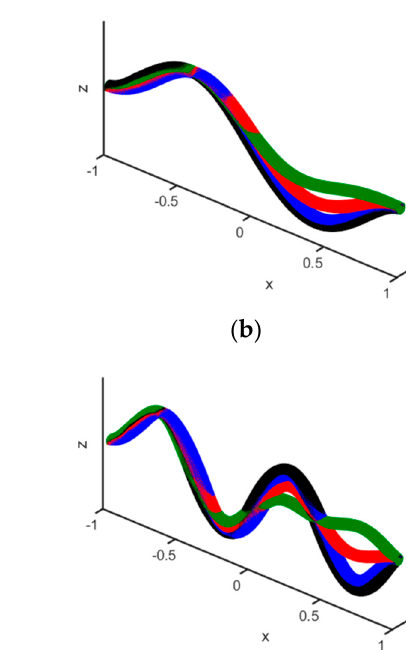
Figure 6. Finite element model for the vibration of clamped-clamped fluid-conveying pipe.